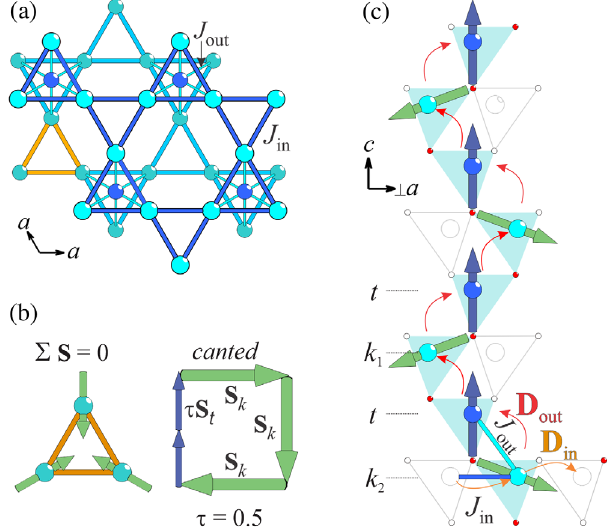
FIG. 1. Swedenborgite structure and exchange. (a) Unit cell of two trimerized kagome ( k ) layers (light and dark cyan) inter- connected by trigonal ( t ) sites (blue) with nearest neighbor AFM superexchange J in the k planes and J out of plane to t sites. in out (b) Minimizing the configurational energy yields two sum rules, (i) implying 120° configurations of spins S on the k triangle k between columns with t sites and (ii) canted configurations of spins S and S on the building unit of the columns, a k triangle k t capped above and below with a t site, depending on the ratio τ ¼ J =J . Spins S within each column tend to align parallel. t out in The case τ ¼ 0 . 5 is proposed for YBaCo 3 FeO 7 [14]. (c) View of the spin columns including t sites (plane ⊥ to a ). All magnetic sites are tetrahedrally coordinated by oxygen, which creates antisymmetric Dzyaloshinskii-Moriya (DM) exchange on all AFM exchange paths, denoted by D and D , coupling the out in spin space to the hexagonal lattice anisotropy. The D vectors, out parallel to the ab plane, connect a t site with three k neighbors and select the seed for a cycloidal structure of threefold symmetry. The in-plane vectors D between k sites enable the in further spreading of the cycloid in the kagome